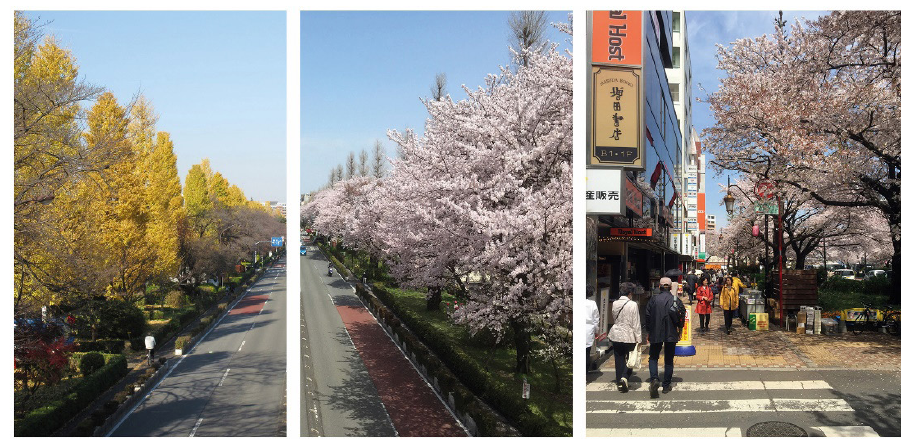
Figure 8. Seasonal variations and versatility of Daigaku-dōri. Scenery in autumn on the left; scenery in spring in the center; eye-level shot on the